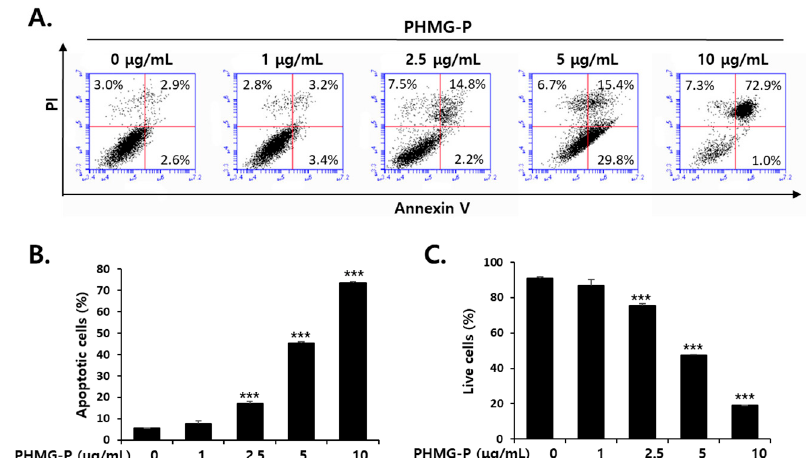
Figure 2. The induction of apoptosis in HepG2 cells treated with PHMG-P. ( A ) The cells were treated with increasing concentrations of PHMG-P for 16 h. Fluorescence-activated cell sorting (FACS) analysis of propidium iodide (PI) uptake and annexin V binding in non-permeabilized cells (lower left, live cells; lower right, early apoptotic cells; upper right, late apoptotic cells; upper left, necrotic cells). The quantification of ( B ) apoptotic cells and ( C ) live cells from three independent experiments. (*** p < 0.001, compared with vehicle-treated cells).